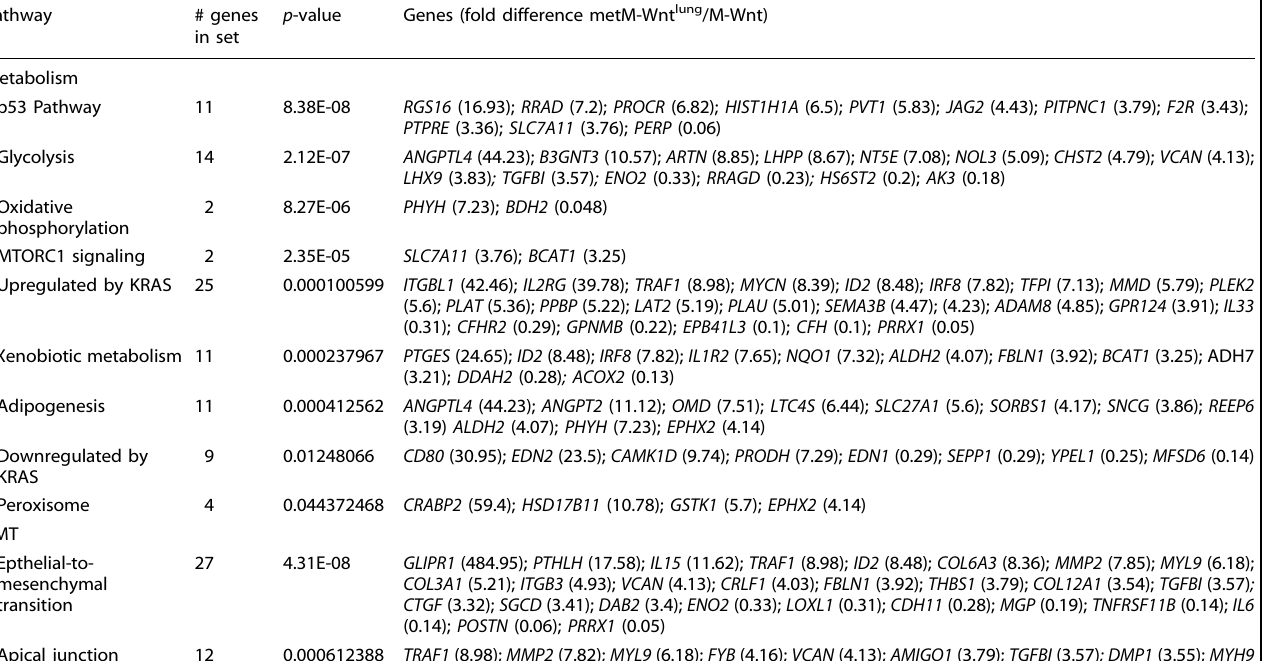
Table 1. Pathway analysis of alterations in metastatic compared to non-metastatic M-Wnt cell